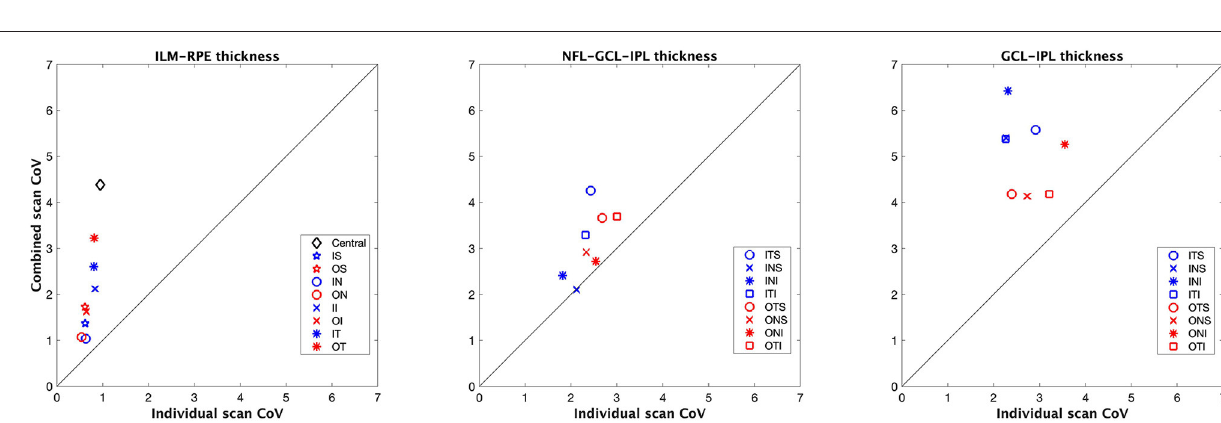
FIGURE 3 | Coefficient of variation (CoV) obtained for the macular thickness measurements for individual and combined scan modes. ILM–RPE, inner limiting membrane to the retinal pigment epithelium; NFL–GCL–IPL, retinal nerve fiber layer, ganglion cell layer, and inner plexiform layer; GCL–IPL, ganglion cell layer, and inner plexiform layer. See Figure 1 legend for sector